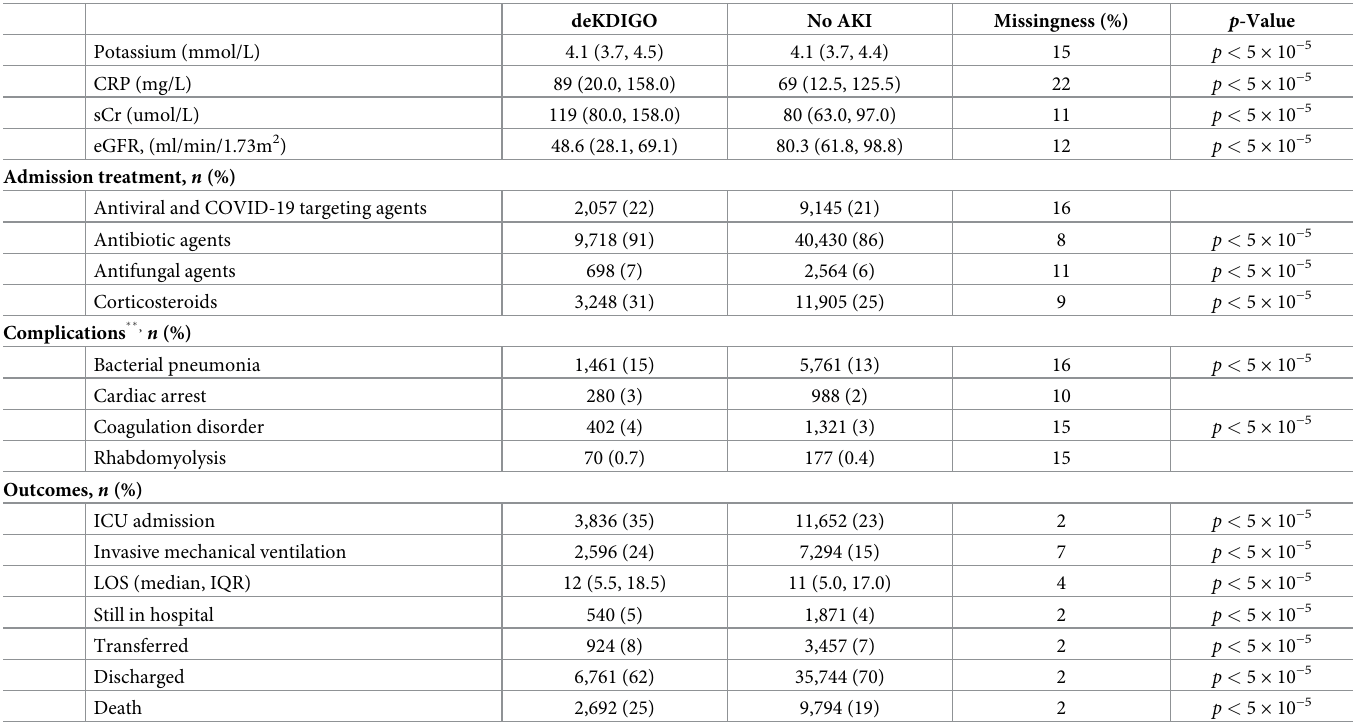
�� Definitions of comorbidities, complications, and outcomes from the CRFs are presented in S2 Table. ACEi, angiotensin converting enzyme inhibitor; AKI, acute kidney injury; ARB, angiotensin II receptor blocker; BP, blood pressure; BPM, beats per minute; BUN, blood urea nitrogen; CKD, chronic kidney disease; COVID-19, Coronavirus Disease 2019; CRF, case report form; CRP, C-reactive protein; eGFR, estimated glomerular filtration rate (estimated using the CKD-EPI equation); HIC, high income; ICU, intensive care unit; IQR, interquartile range; LLMIC, low and low middle-income countries; LOS, length of stay; NSAID, nonsteroidal anti-inflammatory drug; RRT, renal replacement therapy; sCr, serum creatinine; UMIC, upper middle income; WBC, white blood